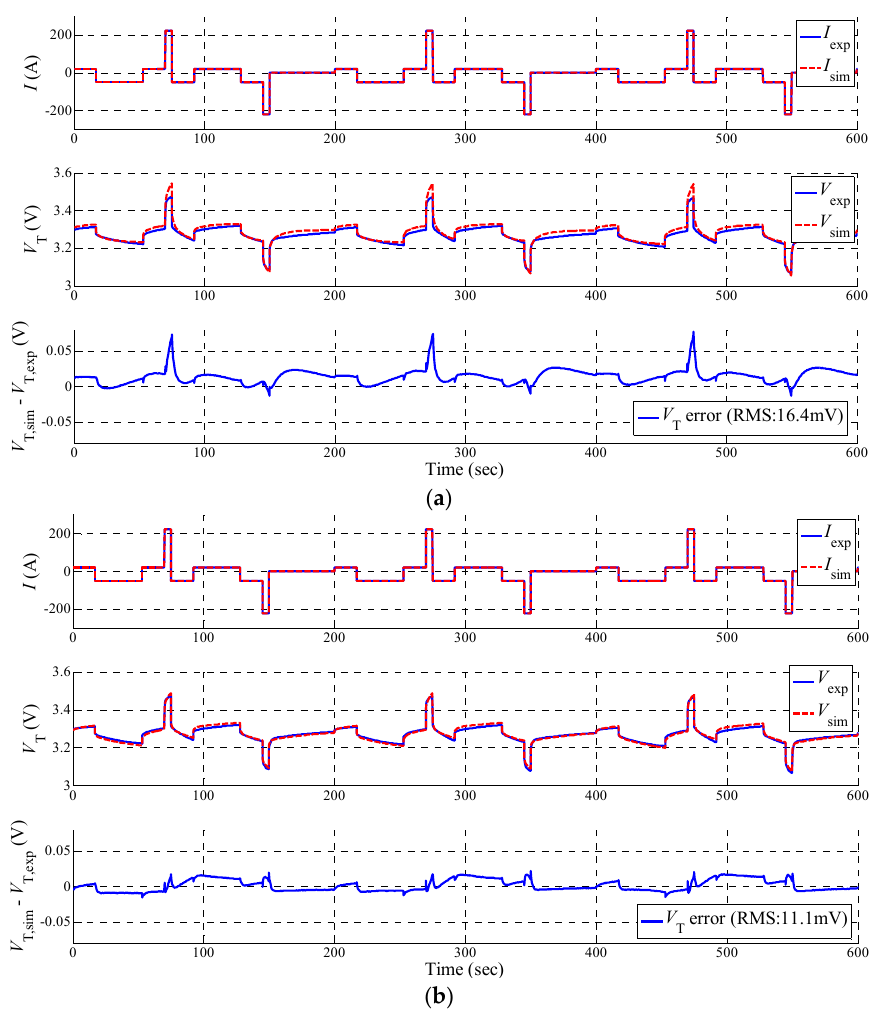
Figure 7. ( a ) Simulation of dynamic stress testing (DST) without considering current dependence of parameters and ( b ) Simulation of DST considering current dependence of parameters.